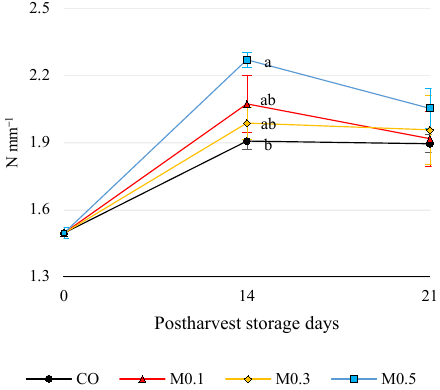
Figure 1. Fruit firmness (N mm − 1 ). Mean values ± SE ( n = 30). By storage time, different letters Figure 1. Fruit fi rmness (N mm − 1 ). Mean values ± SE ( n = 30). By storage time, di ff erent le tt ers indi- indicate significant differences among treatments by Tukey’s test ( p ≤ 0.05). cate signi fi cant di ff erences among treatments by Tukey’s test ( p ≤ 0.05).